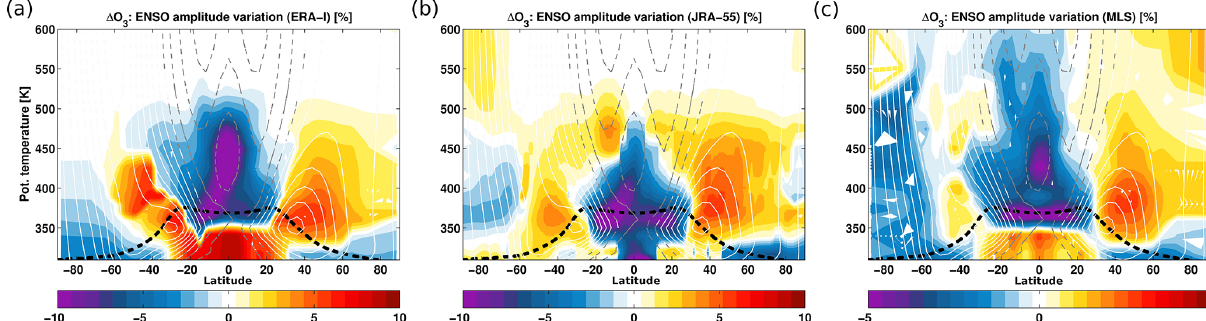
Figure 3. Zonal mean distribution of the ENSO impact on stratospheric O 3 variability from (a) CLaMS simulations driven by ERA-I; (b) CLaMS simulations driven by JRA-55 and (c) MLS satellite observations in percent change relative to the climatological monthly mean mixing ratios. The amplitude of the O 3 variations (term b 2 × SD ( MEI ) ) attributed to ENSO is calculated by projecting the regression fits onto the ENSO basis functions for the 2005–2016 period. Note that there is a factor of 2 difference in the colour scales in (a) , (b) , and (c) , reflecting the difference in the magnitude of the O 3 changes between CLaMS and MLS. Black dashed horizontal line indicates the climatological tropopause from ERA-I (a, b) and JRA-55 c) . Zonal mean wind component u (ms − 1 ), averaged over the 2005–2016 period, from ERA-I is overplotted as solid white (westerly) and dashed grey (easterly)